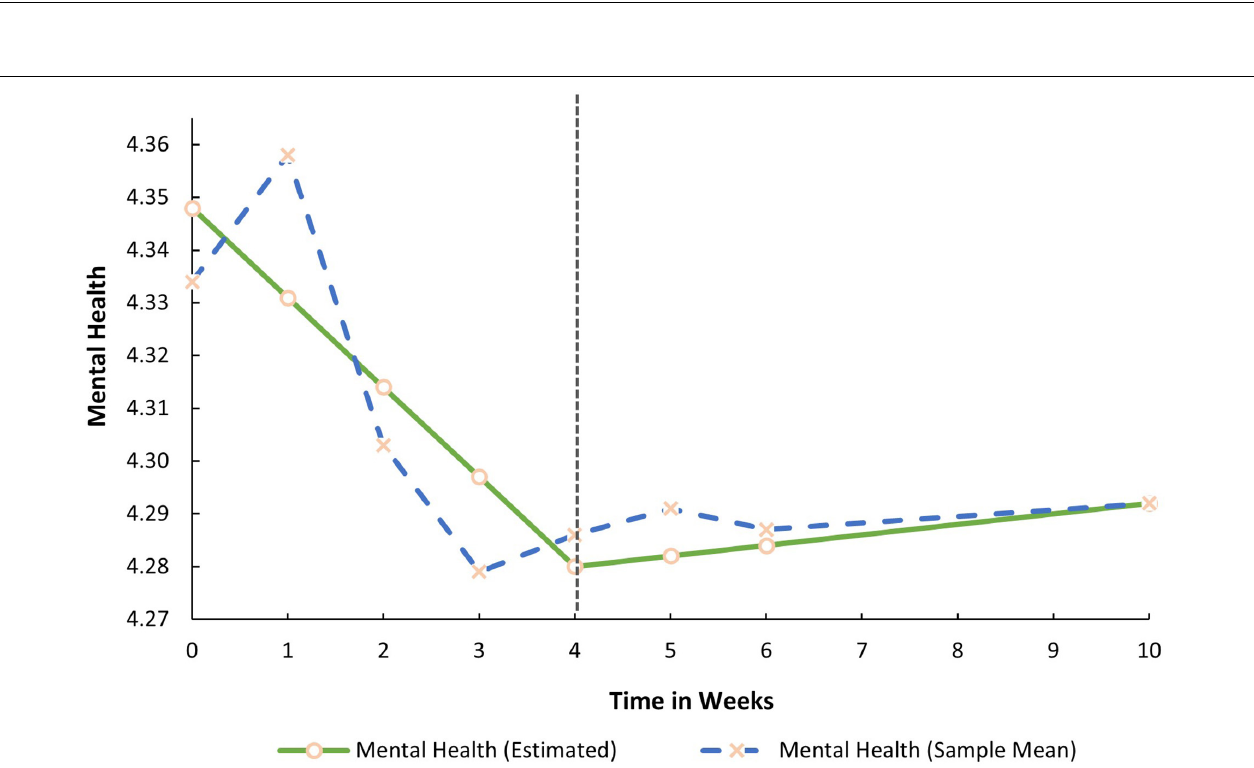
FIGURE 3 | Estimated trajectory of mental health before and during the COVID-19